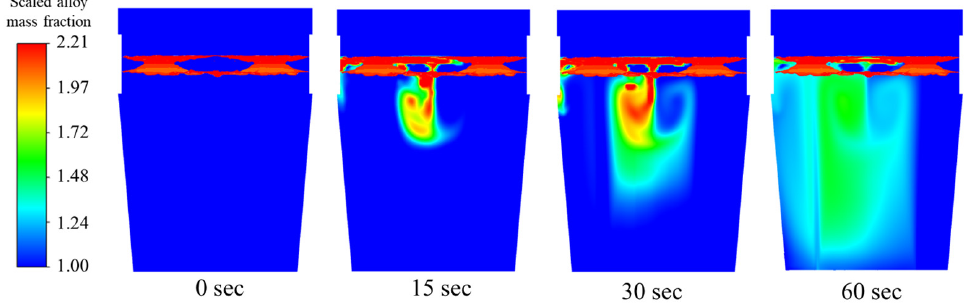
Figure 17. Mixing behavior of vanadium alloy for 1.7 m 3 /min total flow rate. Table 5 record scaled alloy mass fraction for copper, columbium, and vanadium. It